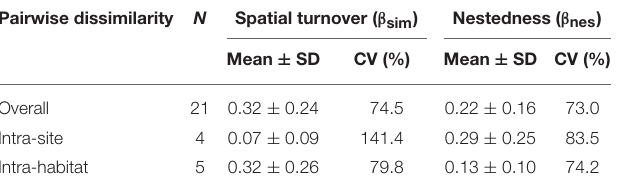
TABLE 2 | Components of dissimilarity between assemblages of birds that consumed fruits of Podocarpus parlatorei in three sites and three habitats in subtropical Andean cloud-forests.